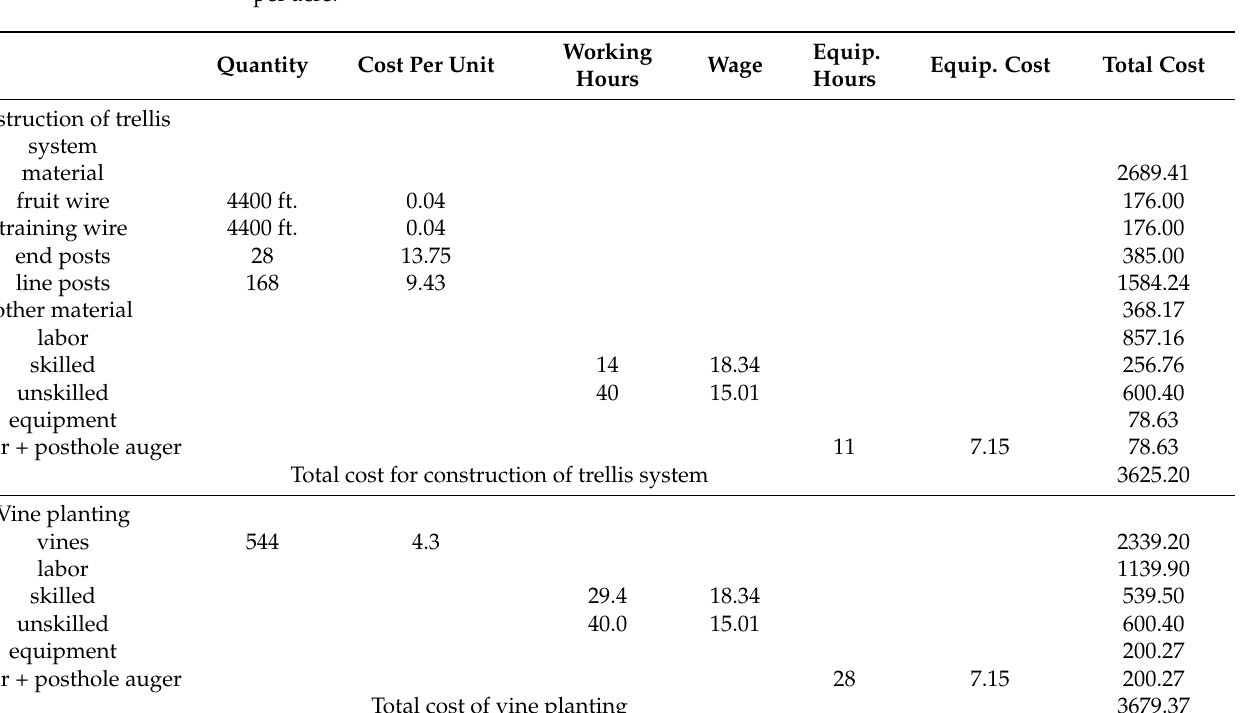
Table 1. Selected investment items for the establishment of an American-hybrid cultivar vineyard, per